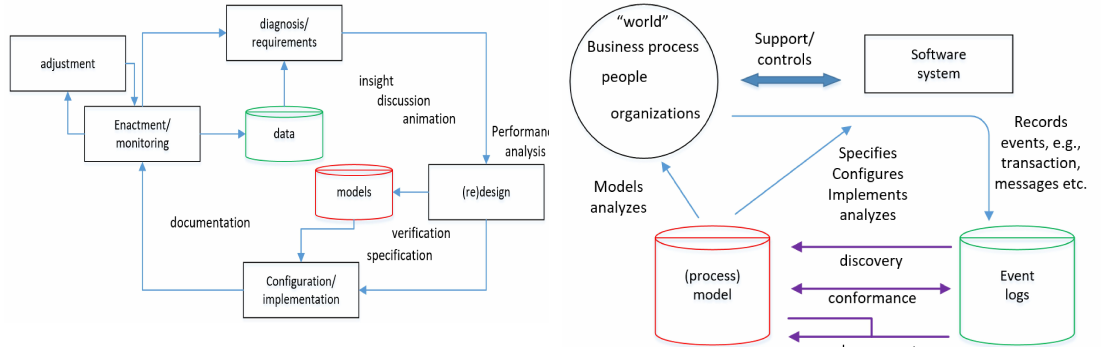
Fig. 2 The placement of the three main types of process